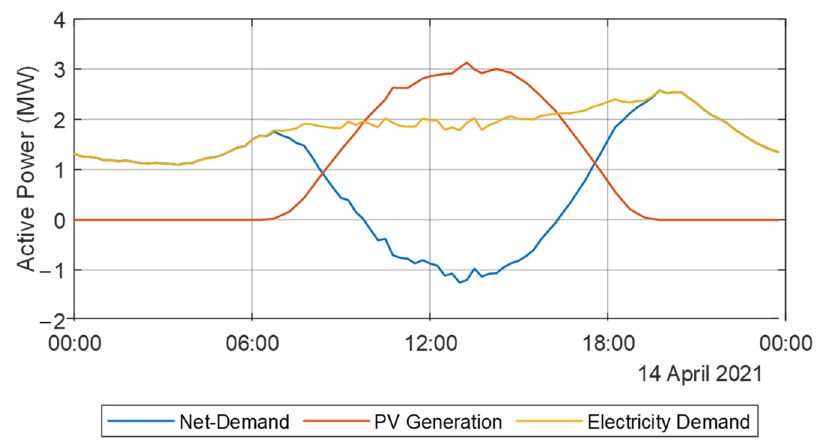
Figure 2. The hourly demand, net demand and PV generation curves for 14 April